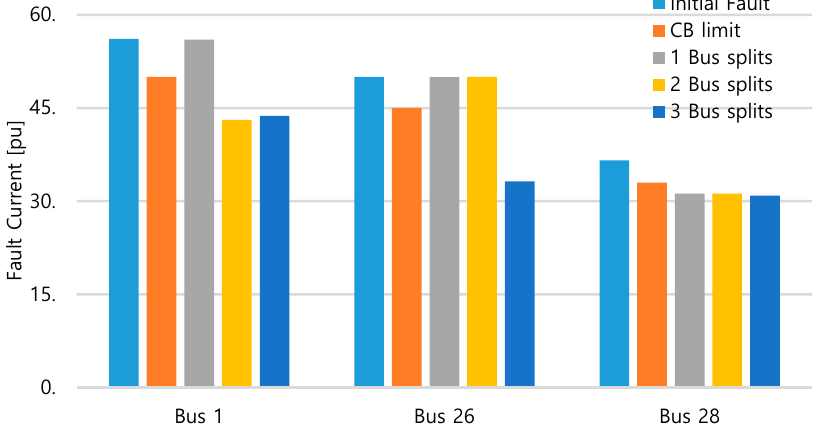
Figure 5. Fault currents at each of the three FLC buses after applying countermeasures in Case